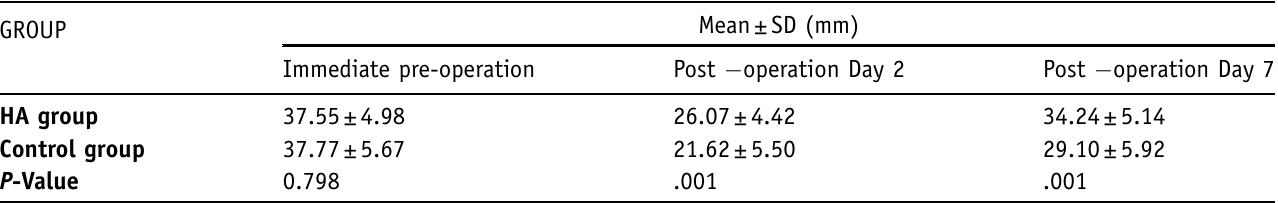
Table III. Evaluation of trismus as mean ± standard deviation (median) in mm. GROUP